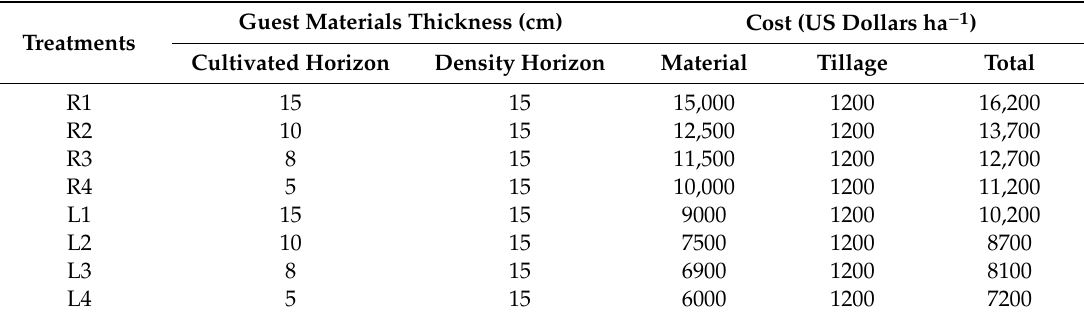
Table 2. Engineering costs of sandy land structural consolidation in di ff erent treatments. Guest Materials Thickness Treatments